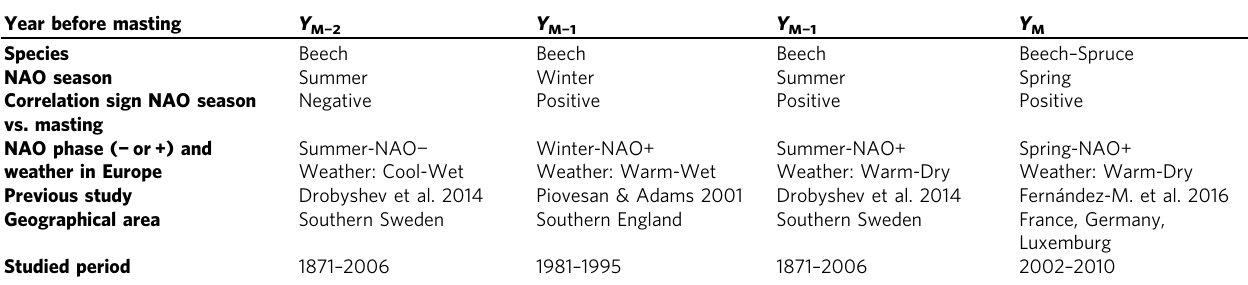
Table 1 Previous fi ndings on the relationship between seasonal NAO indices and beech and spruce masting Year before masting Species vs.